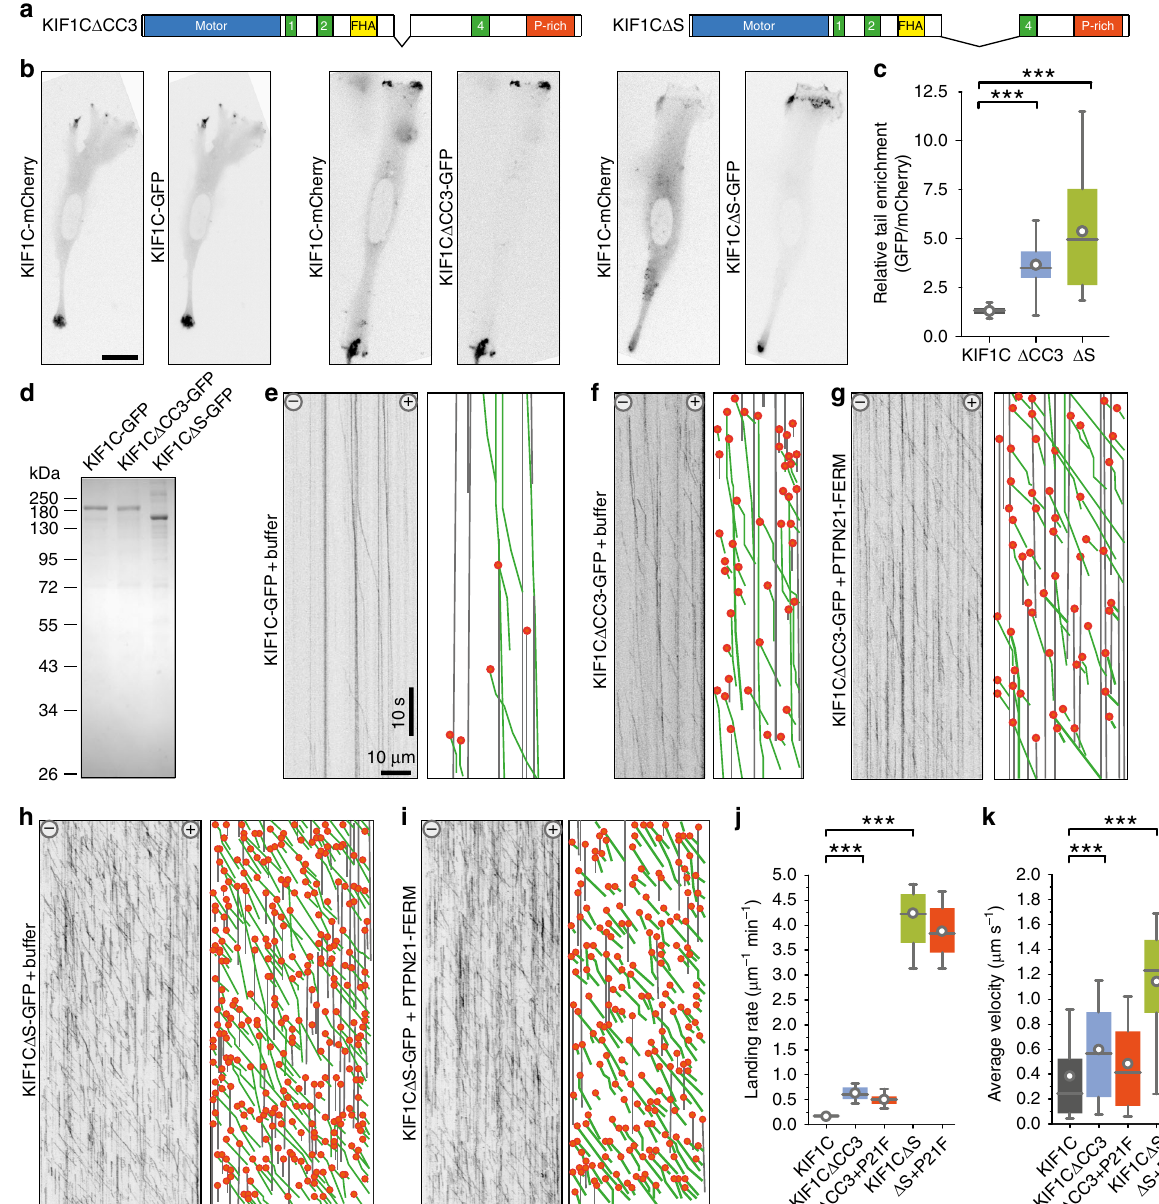
Fig. 6 Deletion of KIF1C stalk results in a hyperactive motor. a Primary structure of hyperactive KIF1C deletion mutants used here. b Representative RPE1 cells co-transfected with full-length KIF1C-mCherry and either KIF1C-GFP, KIF1C Δ CC3-GFP or KIF1C Δ S-GFP and imaged 36 h post transfection. Scale bar is 20 µ m. c Box plot shows ratio of KIF1C enrichment at the tail relative to cytoplasmic levels for GFP vs. mCherry channel. *** p < 0.0005 (Kolmogorov – Smirnov). n = 26, 32, 39 cells. Data are provided in Source Data fi le. d Coomassie-stained SDS-PAGE of puri fi ed KIF1C-GFP and deletion mutants. e – i Representative kymographs from single-molecule experiments. Grey lines indicate immobile motors, green lines running motors and orange dots landing events. j , k Frequency of KIF1C landing events and average velocity of running motors (>25 nm/s). n = 17, 82, 58, 22, 24 microtubules, respectively, pooled from three experiments. *** p < 0.0005 ( t -test with Bonferroni correction). Data are provided in Source Data fi